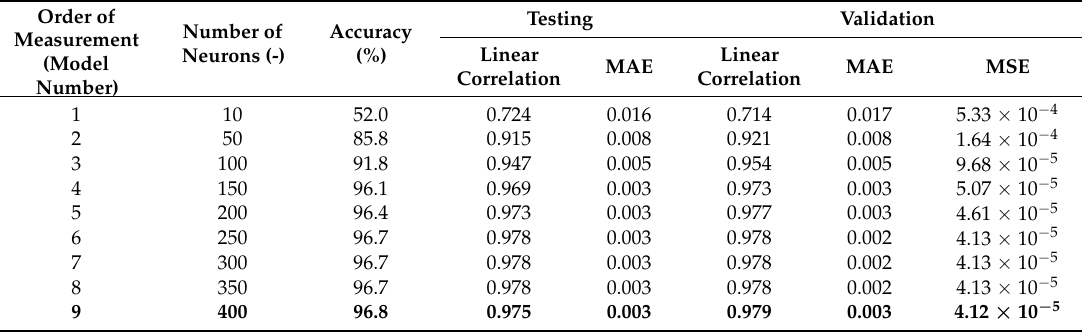
Table 4. The trained models—6 th of November 2018 to 13 th of November